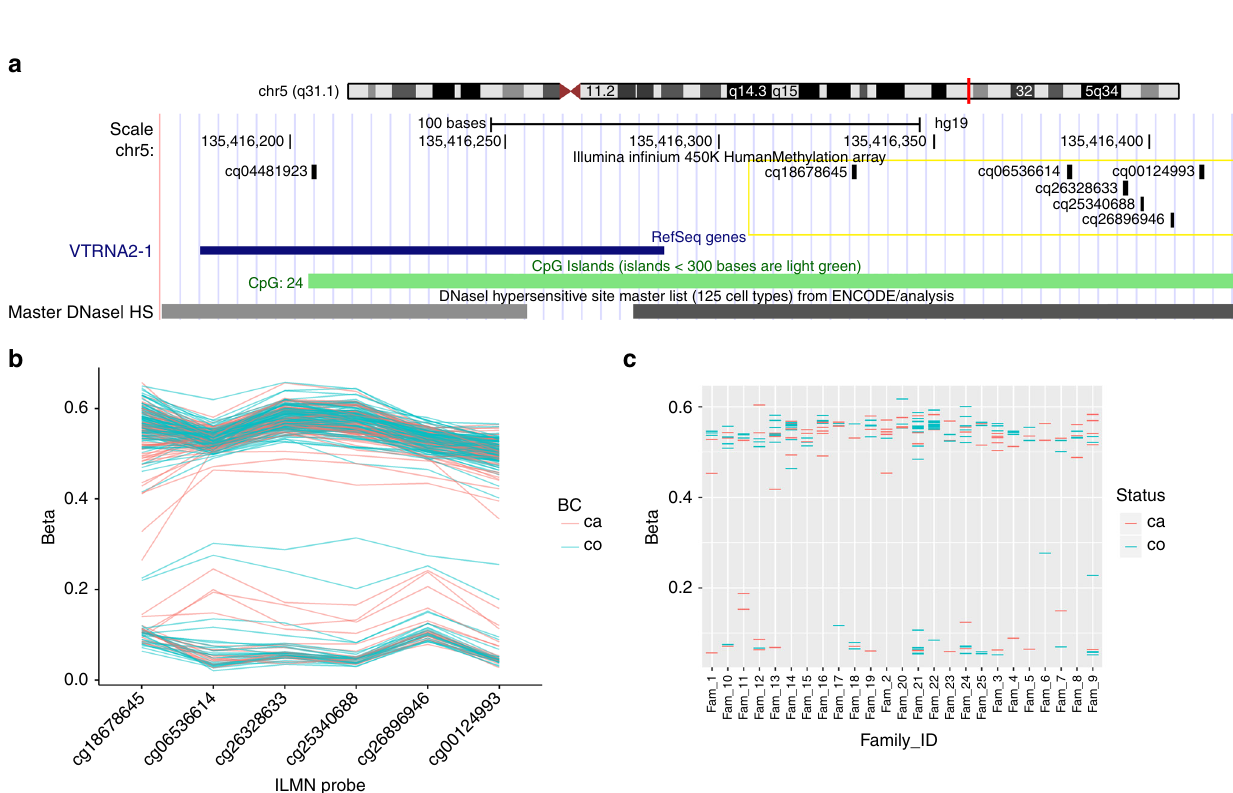
Fig. 2 DNA methylation at the VTRNA2-1 promoter. a Genomic locations of 6 HM450K probes associated with VTRNA2-1 promoter region. b DNA methylation levels ( β -values) of these 6 probes labelled by breast cancer status. β -values for each individual are shown on y axis for 6 VTRNA2-1 probes. c Average DNA methylation levels across all six probes shown separately for individual families and labelled by breast cancer status. β -values are shown on y axis for members from each family ( y axis)